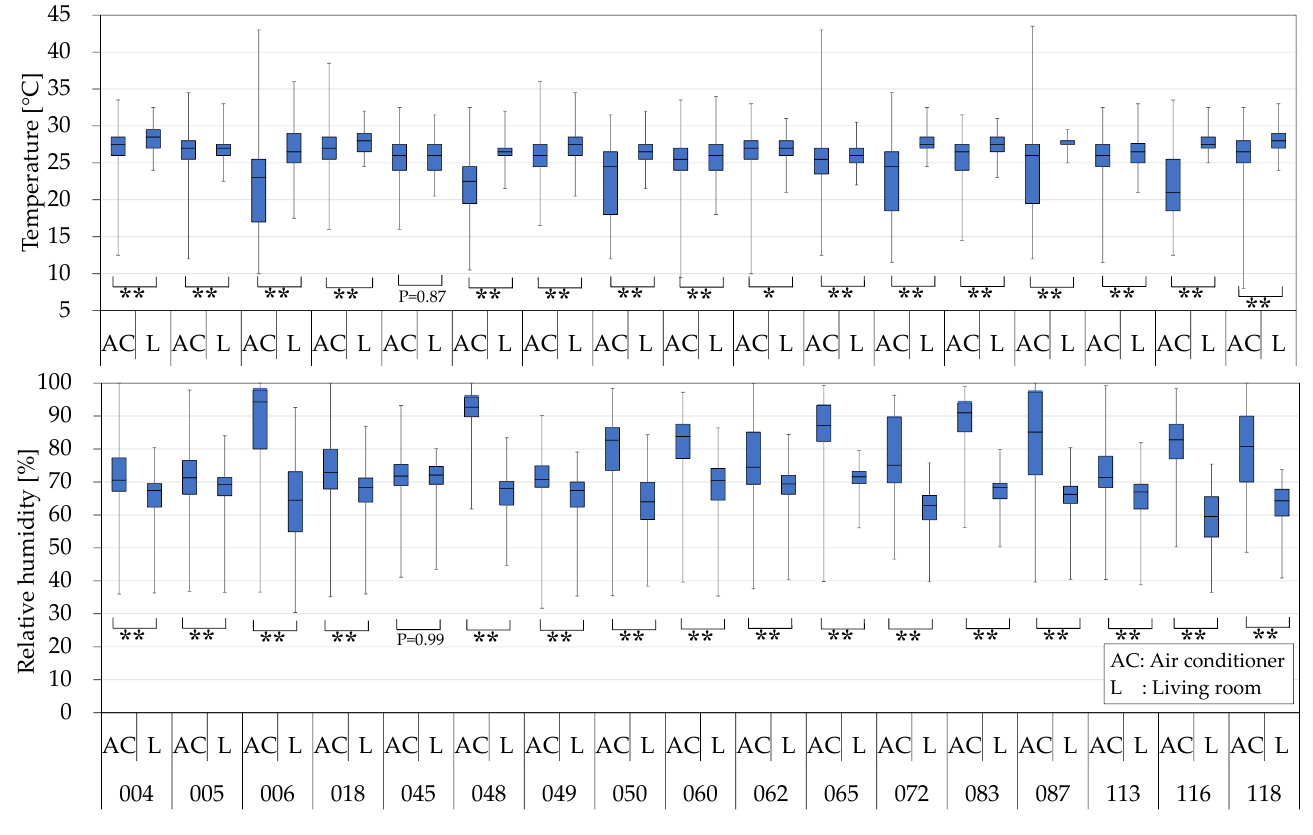
Figure 2 . The quartile values of air temperature and relative humidity of living room and air condi- tioner air Outlet. Statistical significance was evaluated by Mann−Whitney U test. * p < 0.01 , and ** p < 0.001.